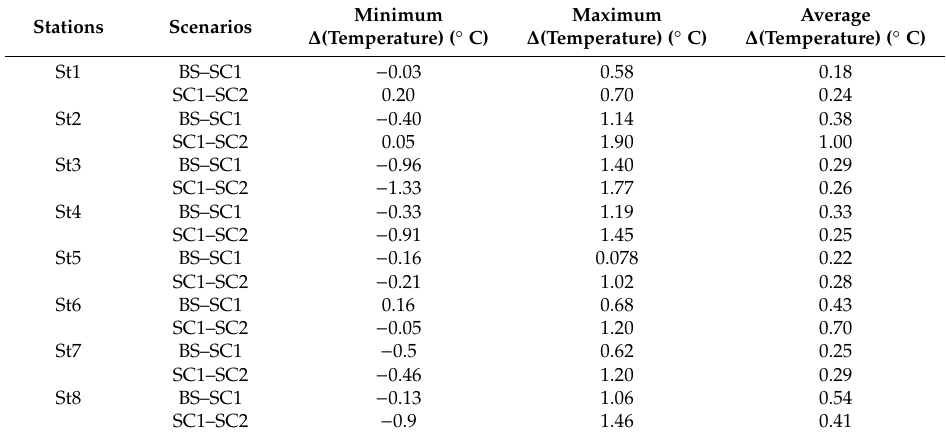
Table 5. Water temperature difference ( Δ( Temperature)) metrics for BS–SC1 and SC1–SC2, and the lagoon stations (St1–St8).